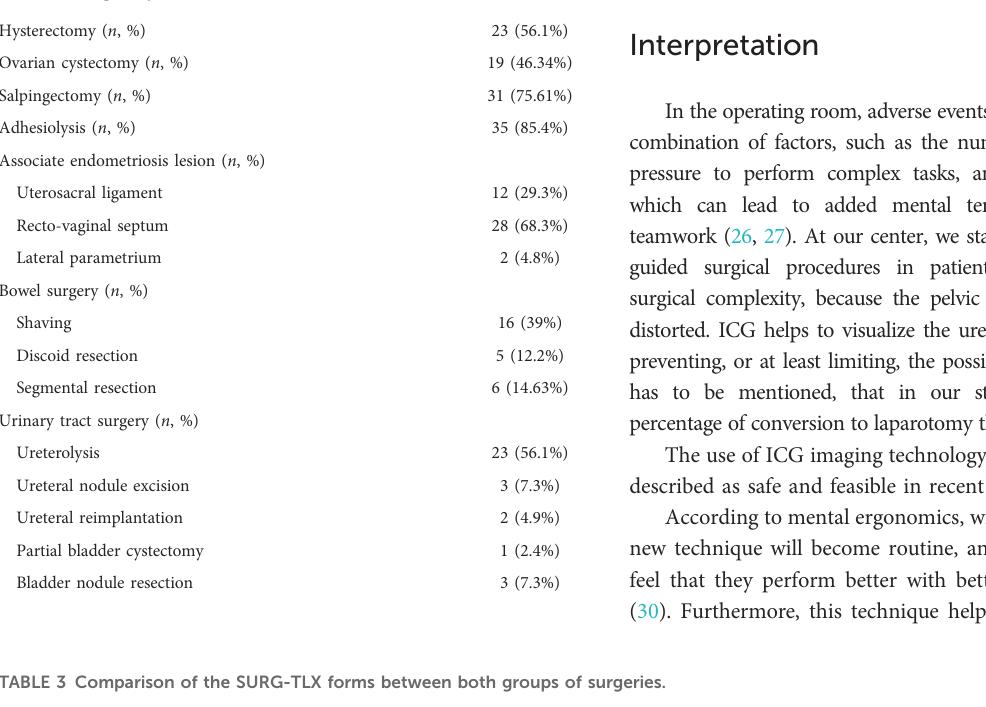
TABLE 2 Surgical procedures.